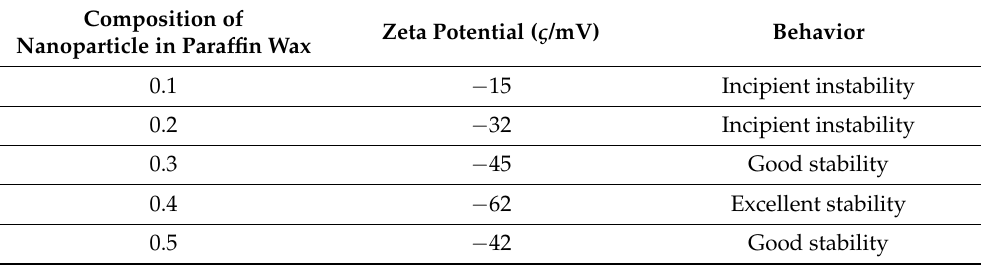
Table 3. Zeta potential analysis of paraffin wax with different compositions of Al 2 O 3 nanoparticles. Composition of